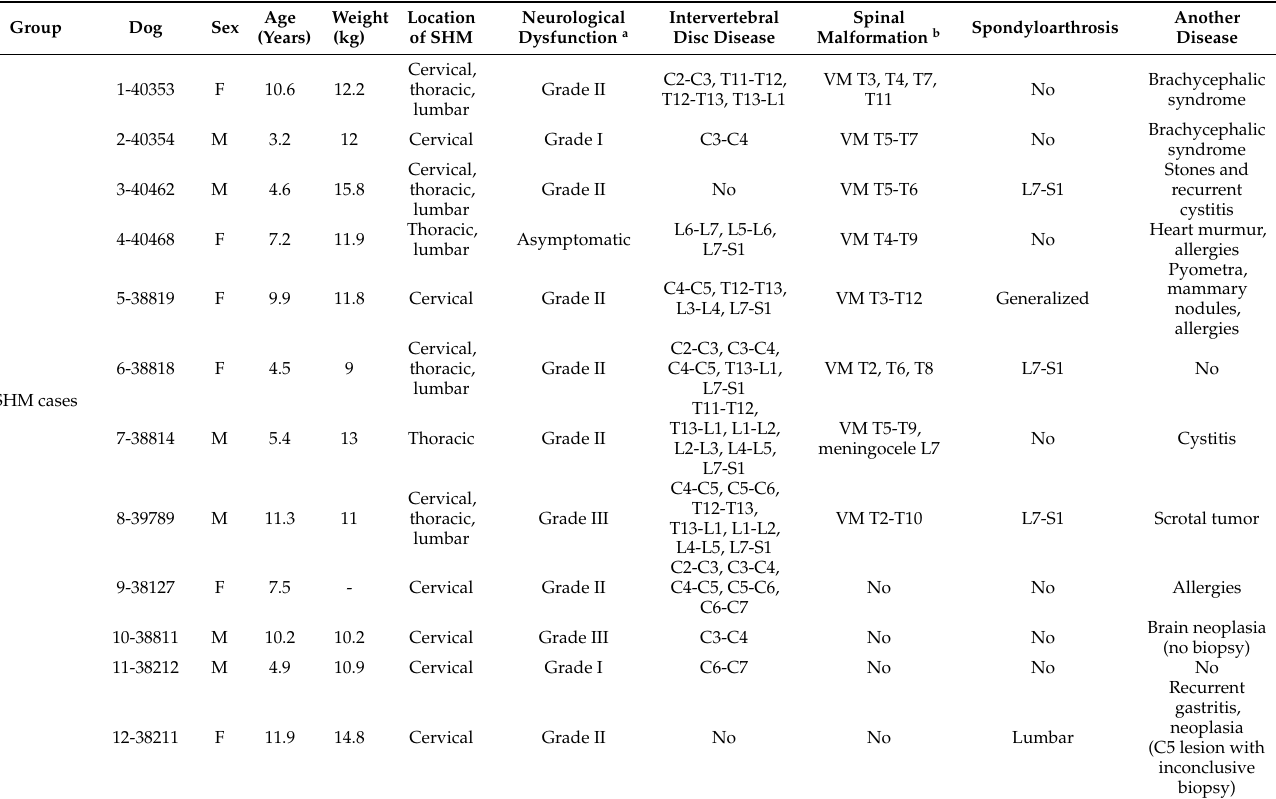
Table 1. Description of the French Bulldog individuals from the Veterinary Neurology Reference Center (VNRC) included in the